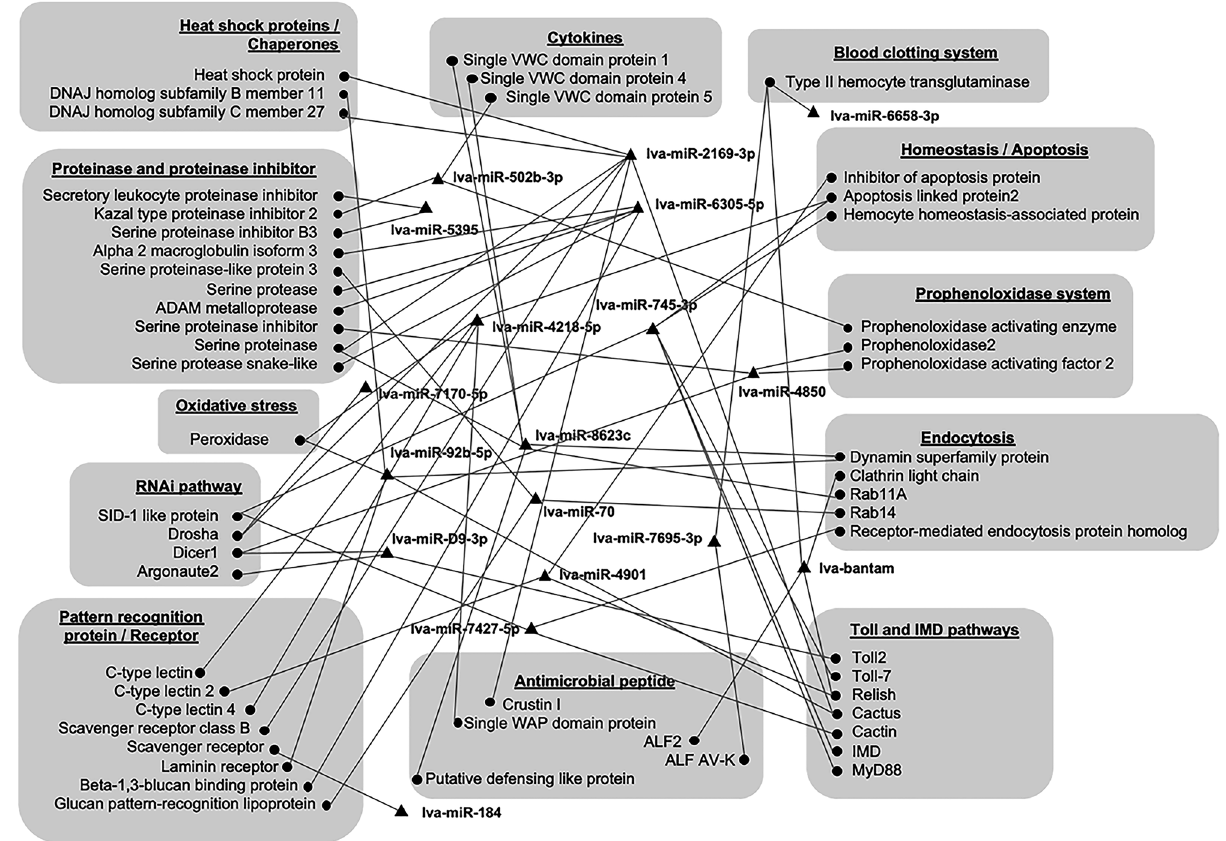
Figure 2. Predicted interactions between miRNAs and target P. vannamei immune genes. The target genes of VP AHPND -responsive miRNAs were predicted against the P. vannamei transcriptome database using the developed miRNA target prediction program. Target genes were grouped according to immune-related